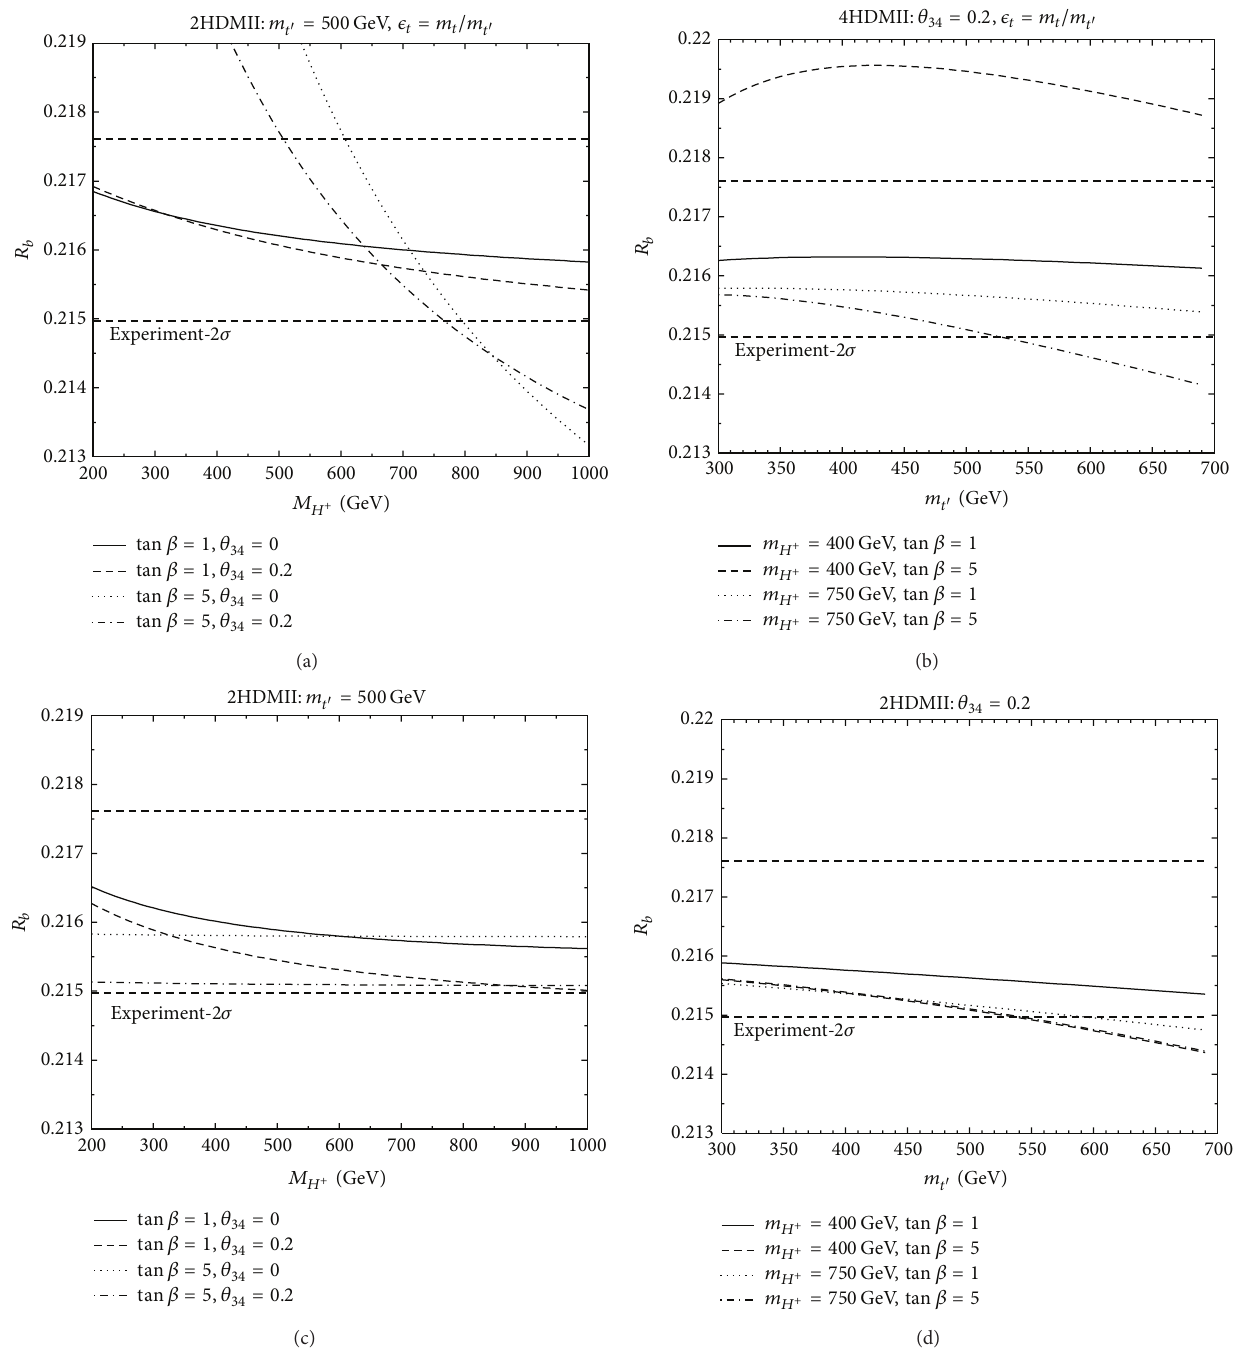
Figure 4: 𝑅 𝑏 in the 4G2HDMI (upper plots, figure taken from [61]) and in the 2HDMII (lower plots), as a function of the charged Higgs mass (left plots) for 𝑚 𝑡 󸀠 = 500 GeV, and ( tan 𝛽,𝜃 34 ) = (1,0), (1,0.2), (5,0), (5,0.2) , and as a function of 𝑚 𝑡 󸀠 (right plots), for 𝜃 34 = 0.2 and [ GeV ], tan 𝛽) = (400, 1), (400, 5),(750, 1),(750, 5) (right). In the 4G2HDMI case we use 𝜖 (𝑚 𝐻 + represent the upper and lower 2𝜎 (measured) bounds on 𝑅 𝑏